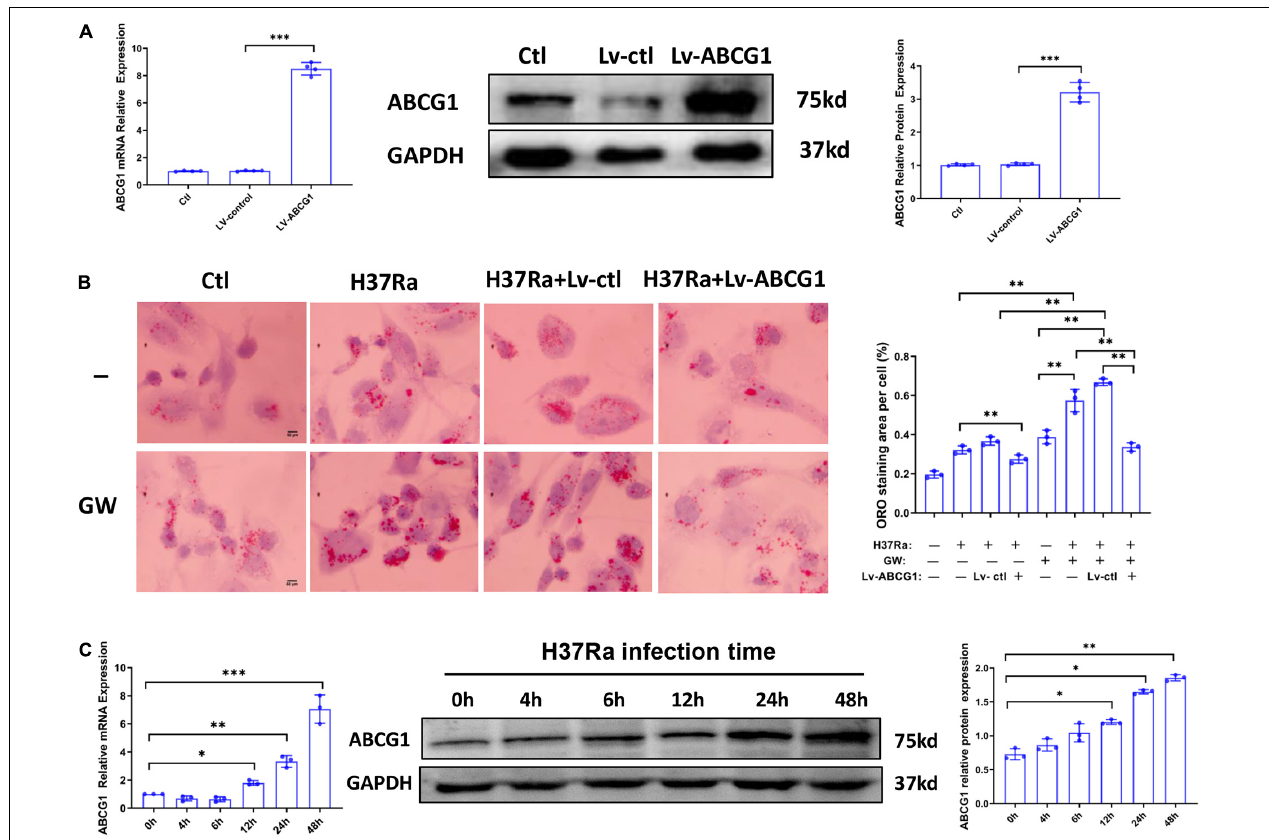
FIGURE 3 | The role of peroxisome proliferator activated receptor γ (PPAR γ ) in regulating foamy macrophage (FM) formation is related to the regulation of ABCG1 expression. THP-1 cells were transduced with Lv-ctl or Lv-ABCG1 for 48 h, followed by the detection of ABCG1 expression by both RT–PCR and western blot (A) . THP-1 cells were transduced with Lv-ctl or Lv-ABCG1 for 72 h, treated with GW9662 for 30 min, infected with H37Ra (MOI = 10:1) for 72 h and then evaluated for intracellular lipid accumulation by ORO staining [ (B) , left panel, 1,000 × ]. Scale bar = 50 µ m. The intracellular lipid bodies were quantified with ImageJ software [ (B) , right panel]. Effects of Mycobacterium tuberculosis ( Mtb ) infection on ABCG1 expression in THP-1 cells were detected. THP-1 cells were infected with H37Ra for the indicated times and then harvested for the detection of ABCG1 expression by RT–qPCR and western blot (C) . Data are expressed as the means ± SD of at least three independent experiments. ∗ P < 0.05, ∗∗ P < 0.01, ∗∗∗ P <